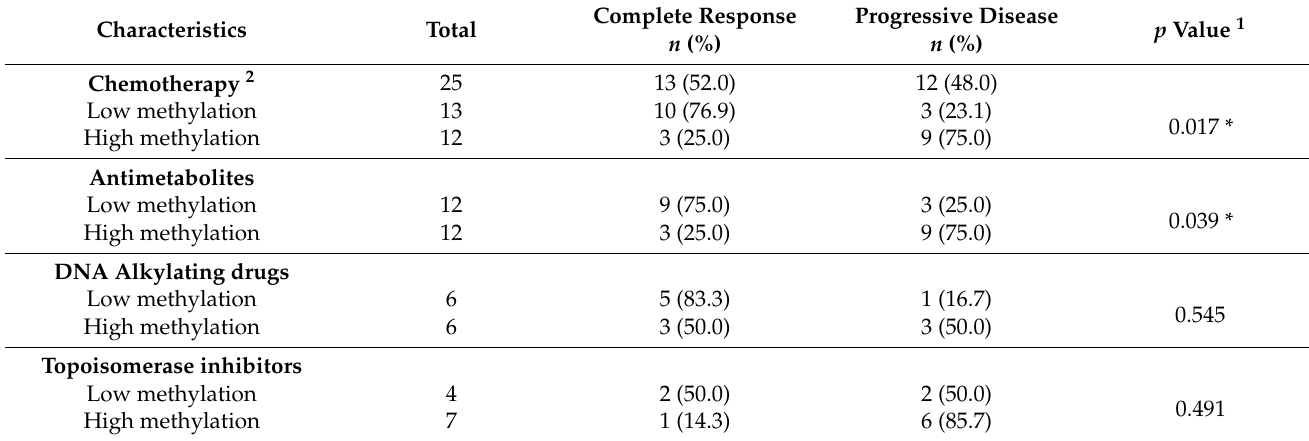
Table 3. EHD3 promoter (cg01163837) hypermethylation in relation to drug treatment response in the TCGA cohort.